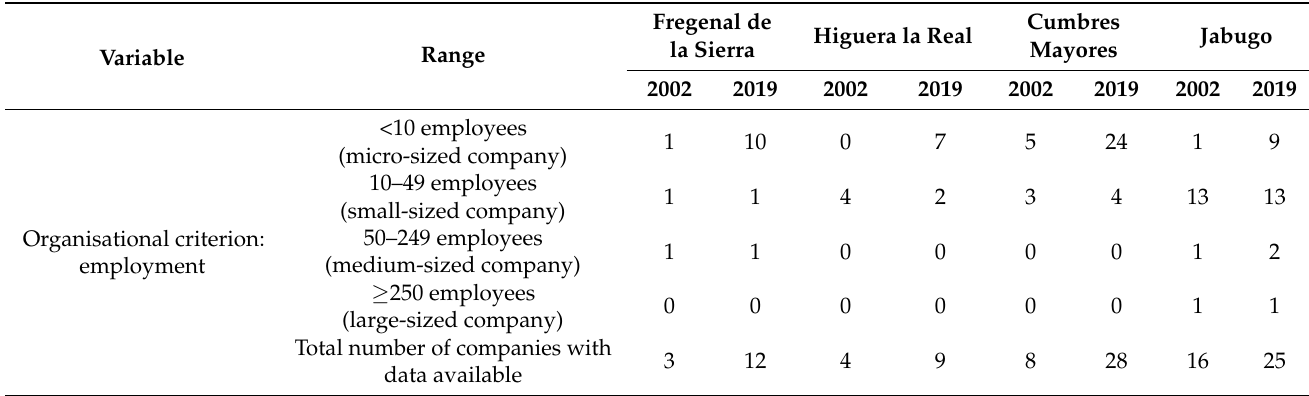
Table 7. Range-size classification of companies in the LPS-IPTI according to the organisational criterion (employment) (2002 and 2019) 8 .